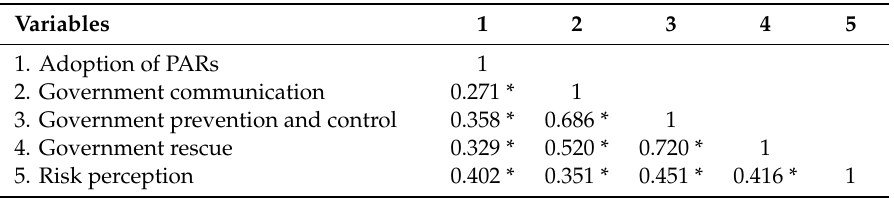
Table 3. Correlations of government intervention, risk perception, and the public’s adoption of protective action recommendations